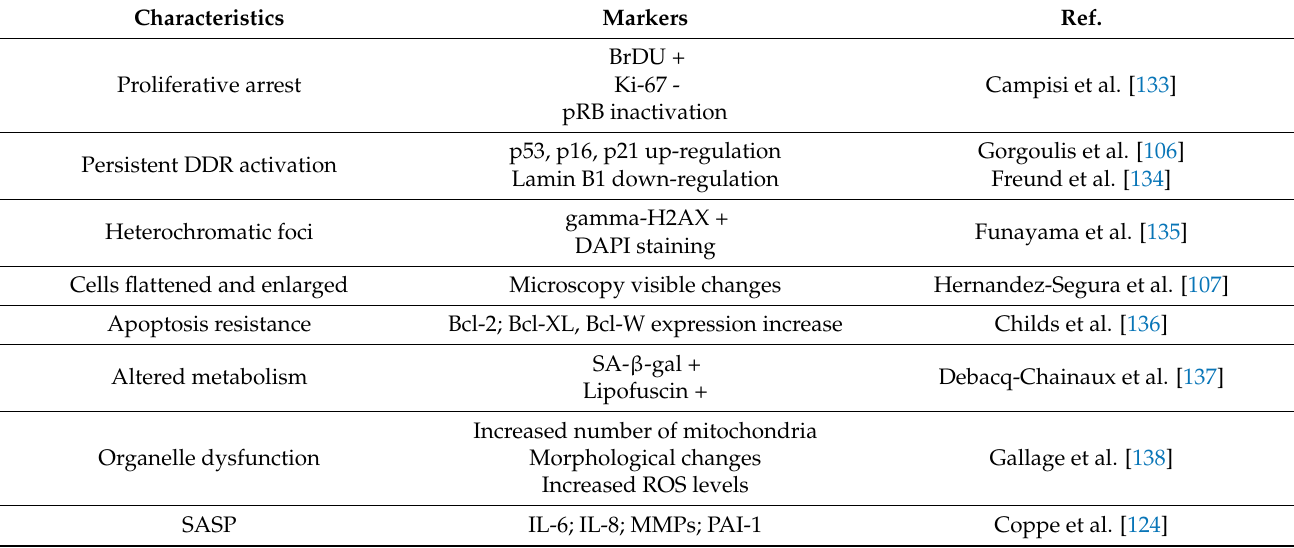
Table 1. Cellular senescence characteristics and